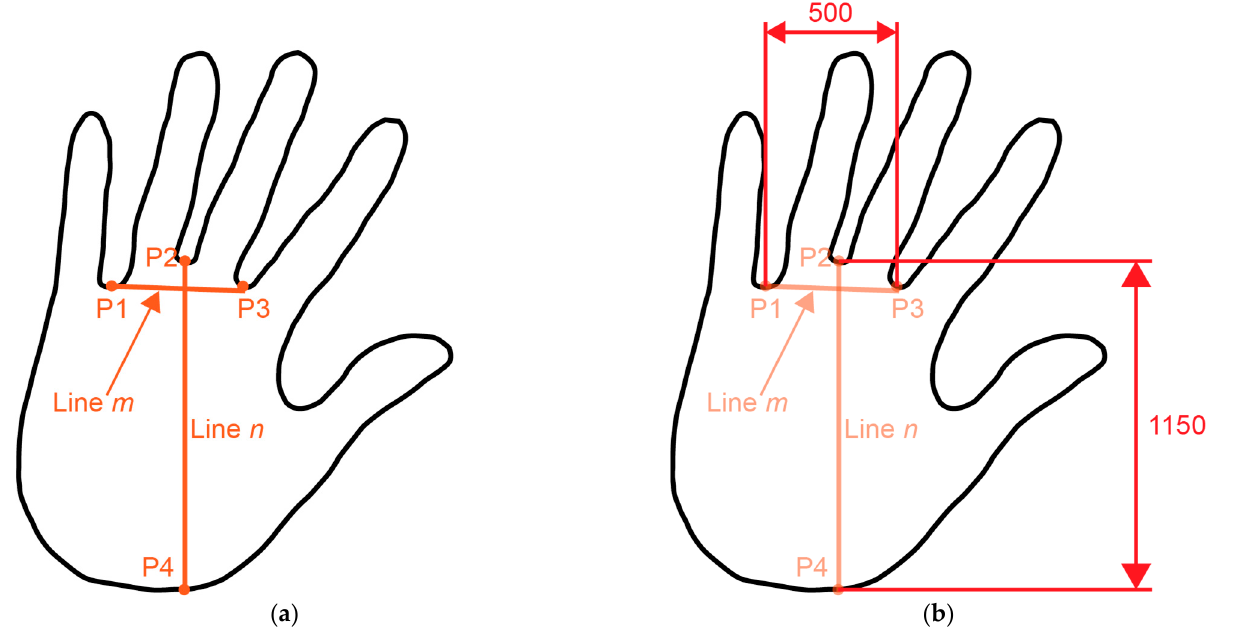
Figure 5. Contact areas during the handshake, as deduced experimentally: ( a ) green ink that was applied to the palm and fingers of each participant’s right hand; ( b , c ) green ink was transferred to another participant’s hand during a handshake.